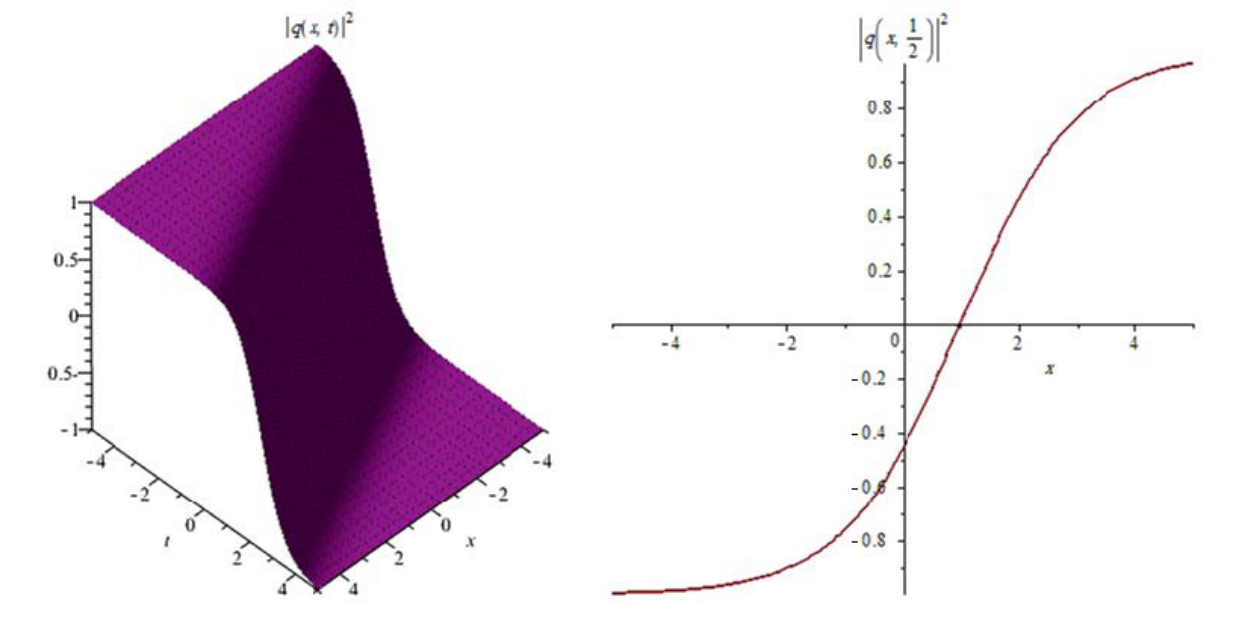
Figure 10. The profile of the combination of dark-bright soliton solutions (51). Figure 11: The numerical simulations of the solutions (51) 3D and 2D (with t = 1 with the parameter values a 1 = 4, a 2 = 1, b = 21, σ = 1, α = 1, κ = 2, w = 24, λ = 2, − µ = 2, c = 10, v = 6, 5 5. x , t − − ≤ ≤